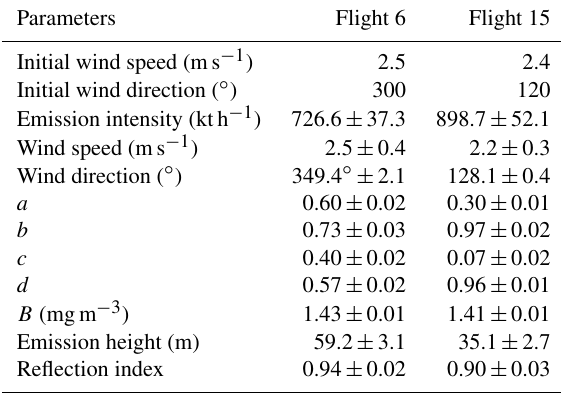
Table 2. CH 4 emission retrieved by two meteorological data sources.